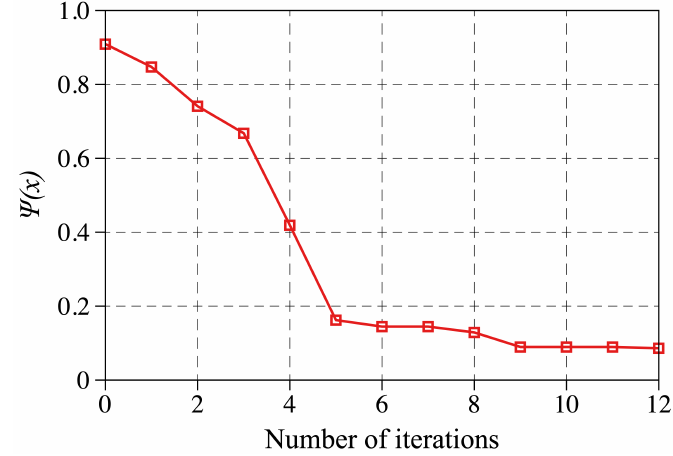
Figure 8. The objective function given by Equation (16) evaluated and plotted against the number of iterations to show the convergence behavior of the inverse problem employed in this study to find the M-R material parameters.